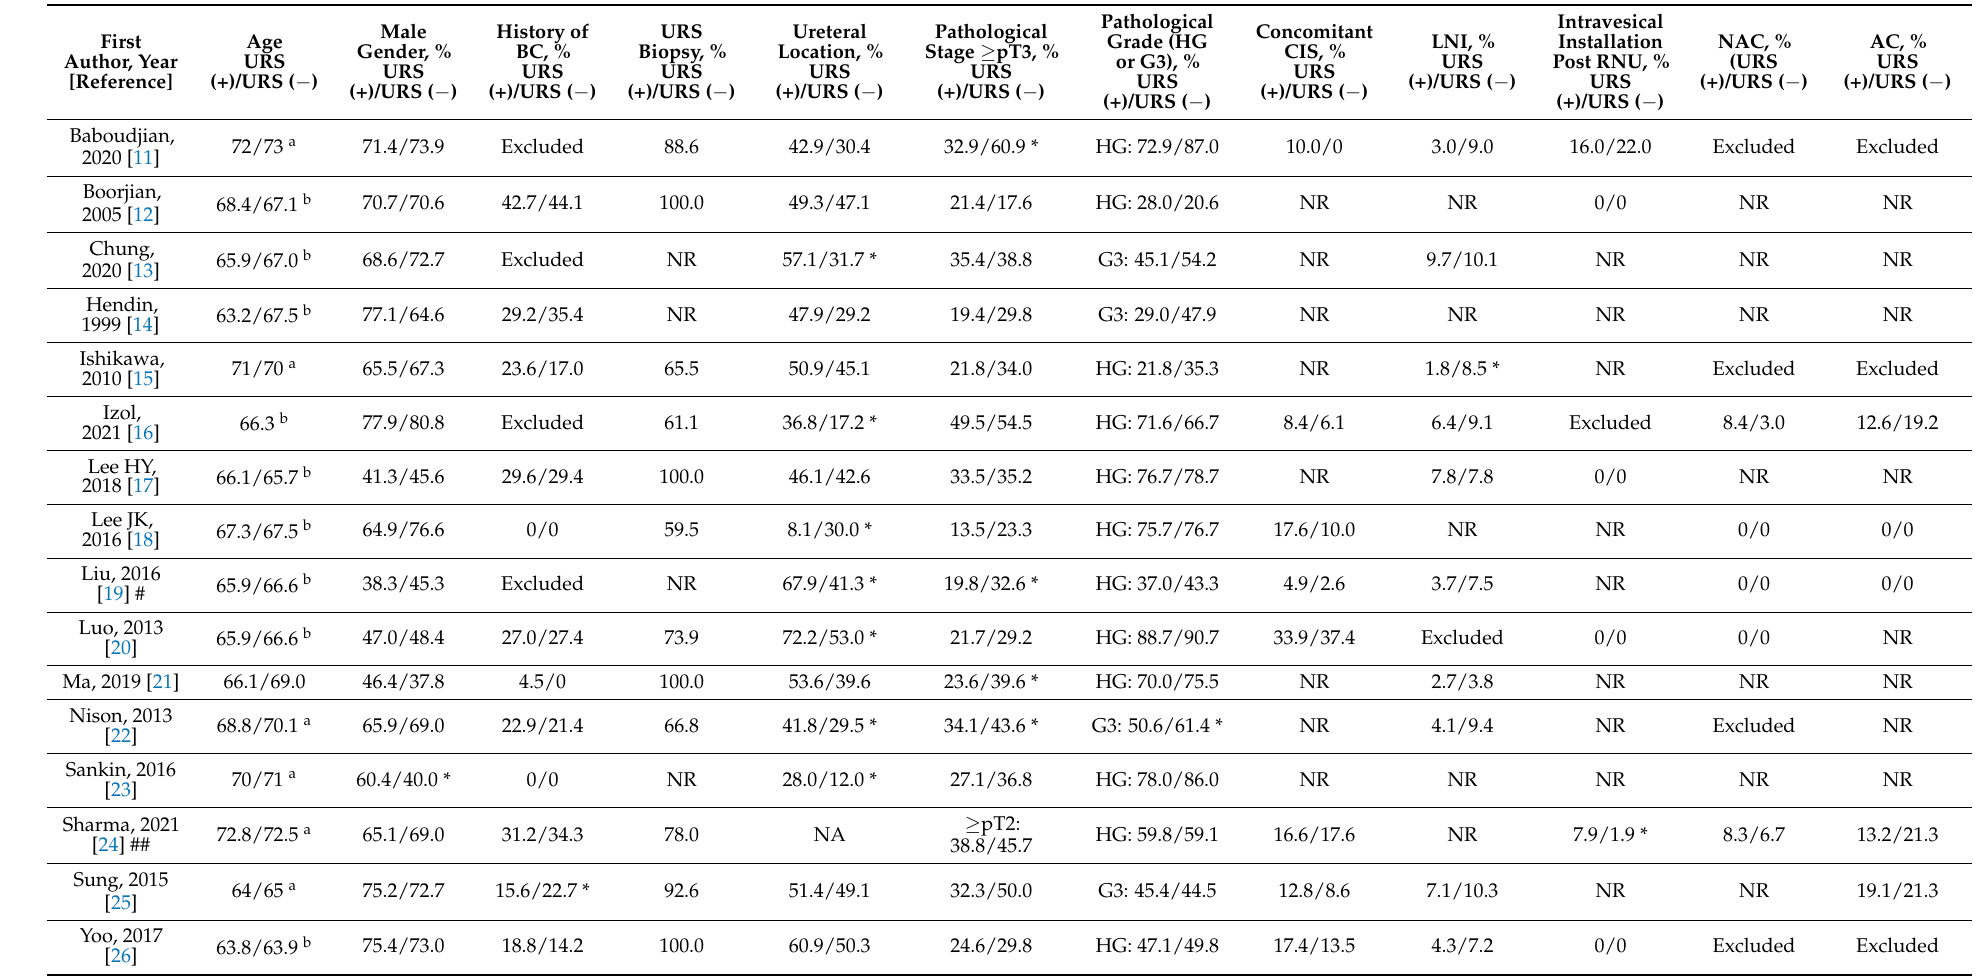
Table 2. Clinical and pathological characteristics of included